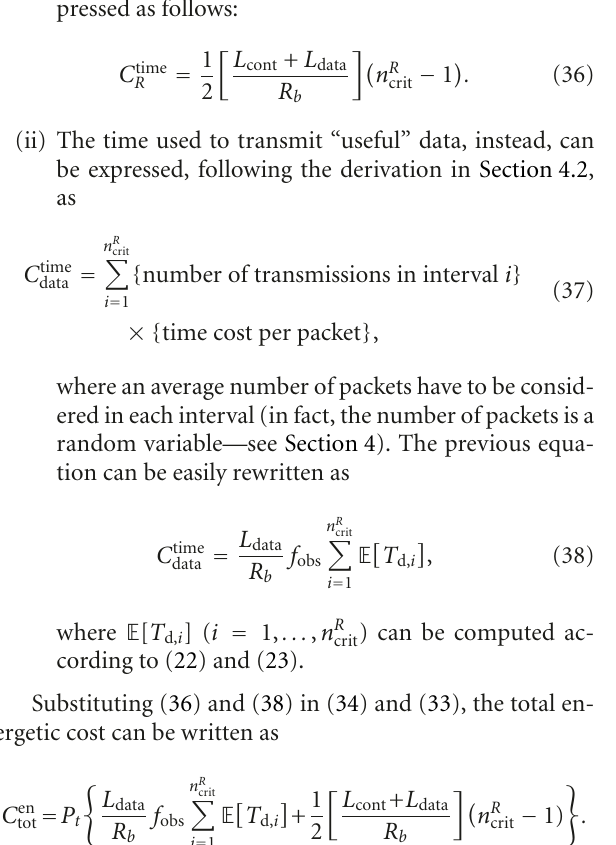
Figure 12: Energy penalty, associated with the reclustering proto- col, as a function of both the observation frequency f obs and the number of sensors N . Two possible cases are considered: (a) maxi- mum penalty (associated with a sensor which survives until the end) and (b) average penalty (among all the sensors in the